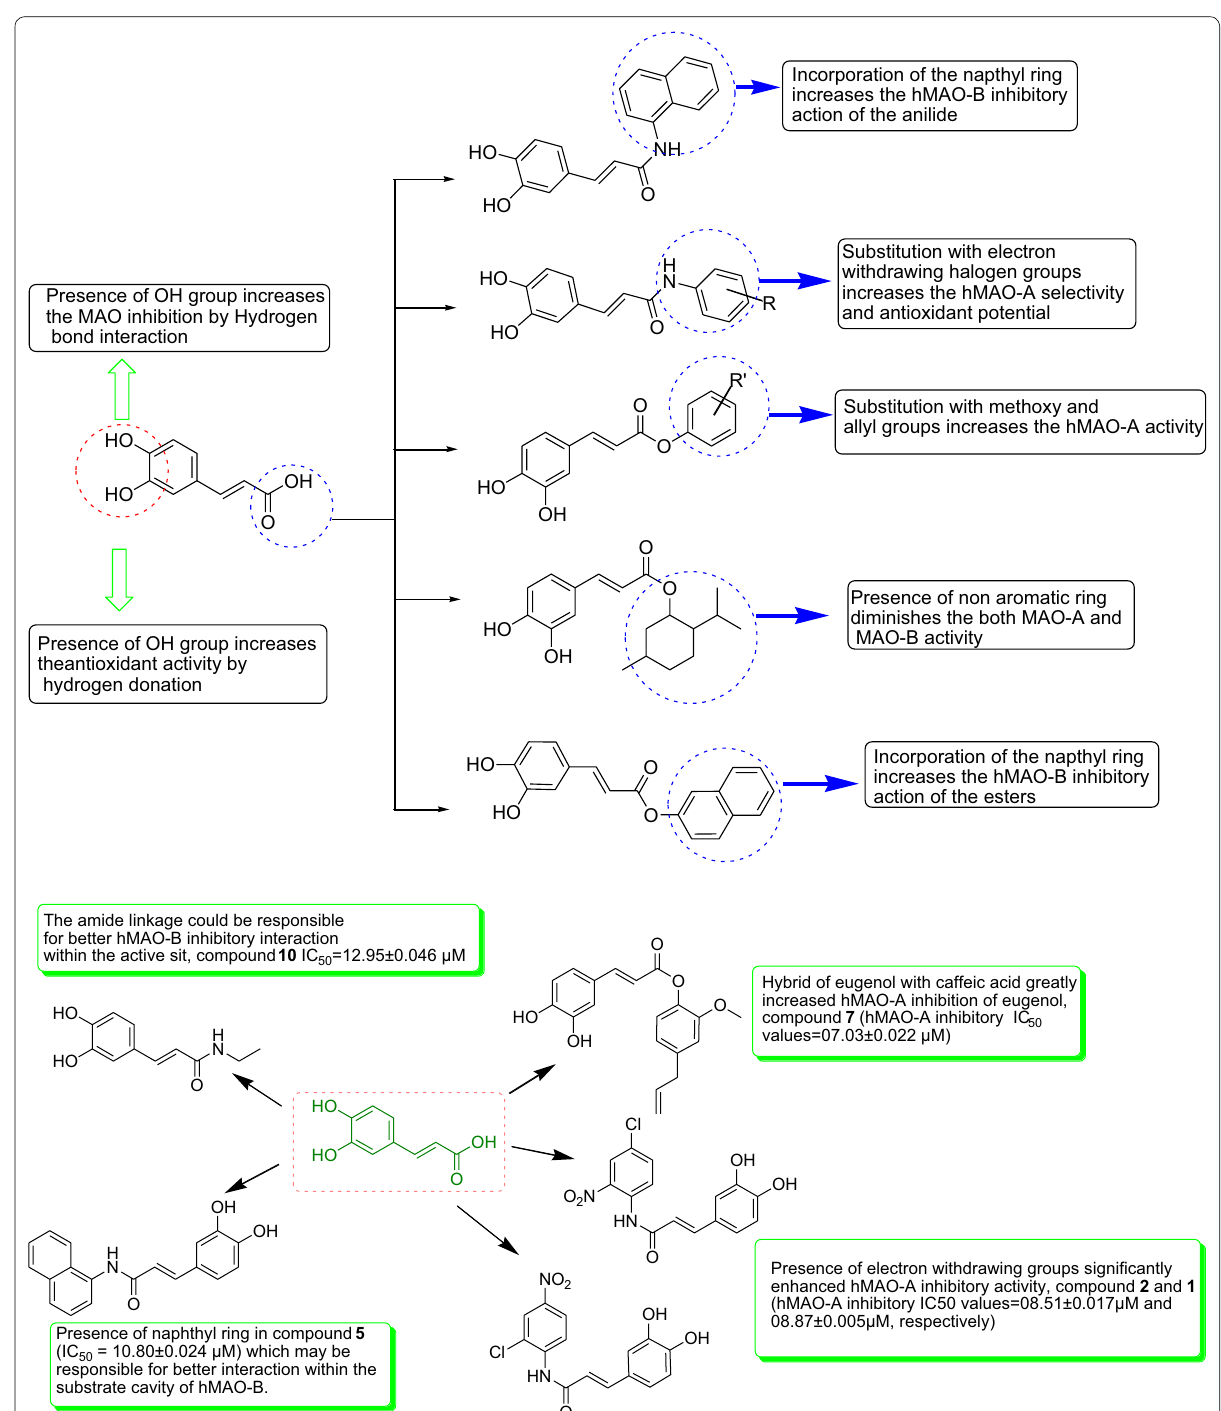
Presence of naphthyl ring in compound 5 (IC 50 = 10.80±0.024 µM) which may be responsible for better interaction within the substrate cavity of hMAO-B. Fig. 8 Careful insight into an examination of the MAO screening and antioxidant assay explicated of some SARs, along with few active compounds as significant MAO-A and MAO-B